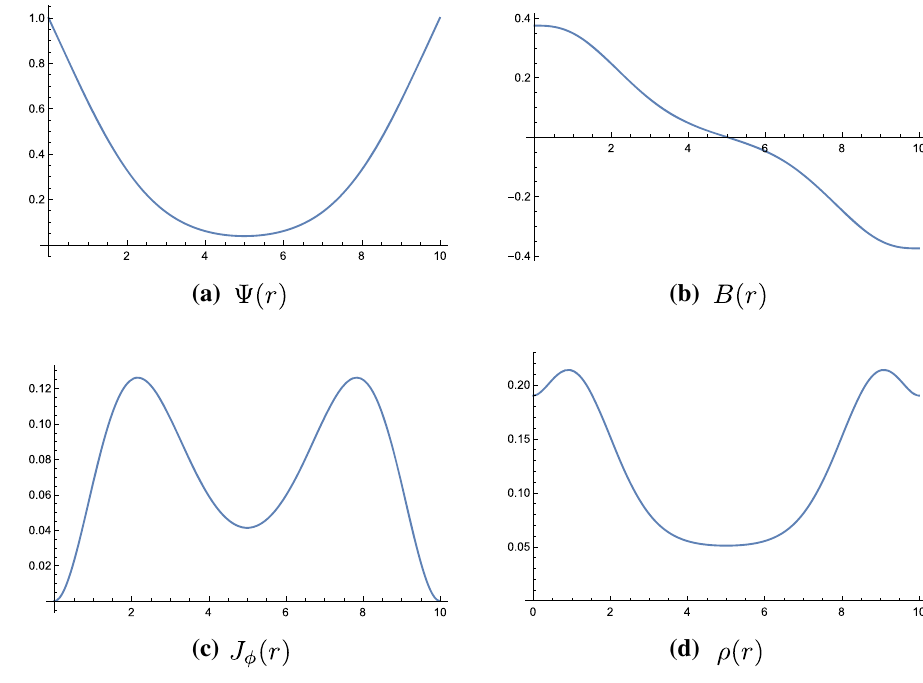
Fig. 9 Profiles for the gauged baryon solution n = 0 with periodic boundaries for (cid:16) . The profile function F ( r ) is defined by E 0 = π 2 / 2 R